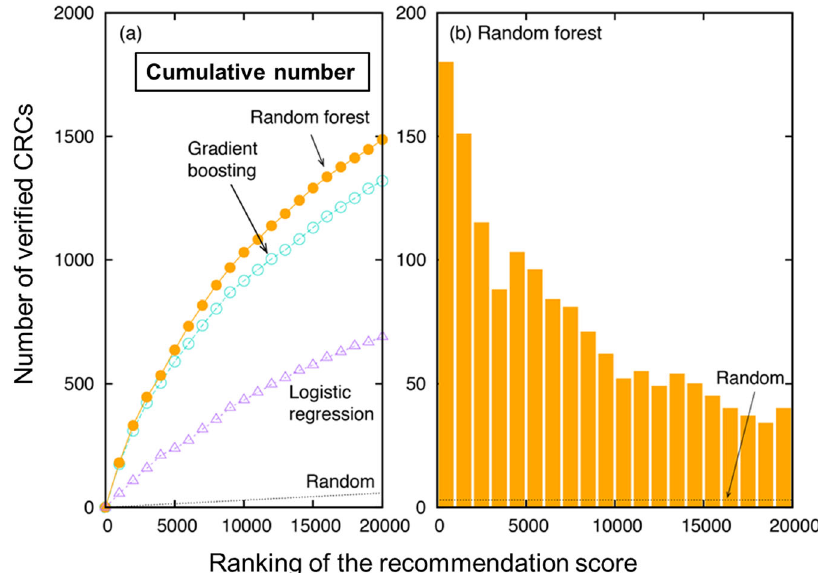
Fig. 2 The numbers of veri fi ed CRCs for pseudo-binary compositions with the ranking of the recommendation scores. a The cumulative numbers of veri fi ed CRCs by three classi fi ers, i.e., random forest, gradient boosting, and logistic regression, are compared with that by random sampling. b The histogram by the random forest method, i.e., the differential form of a for the random forest